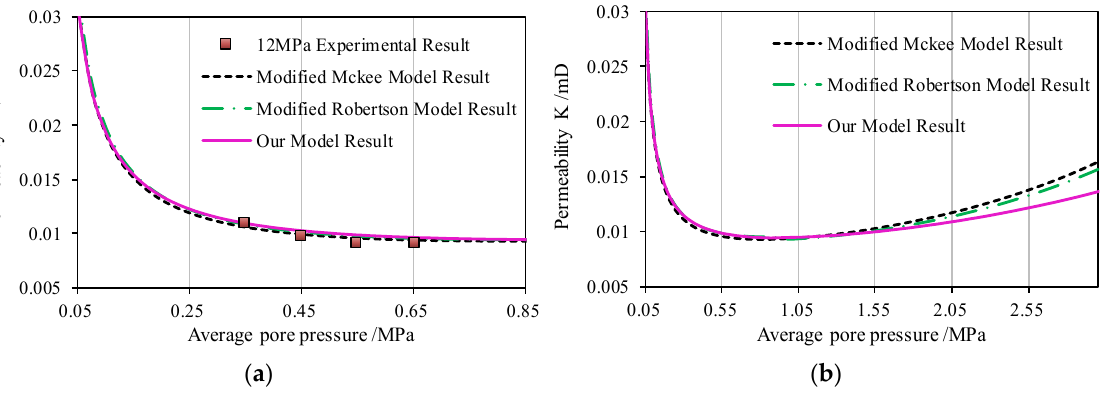
Figure 12. Calculation results of the permeability models under a hydrostatic stress of 12 MPa and the corresponding experimental data of sample M2. ( a ) Comparison of the permeability models with the experimental data. ( b ) Calculation results for a wider pore pressure range.